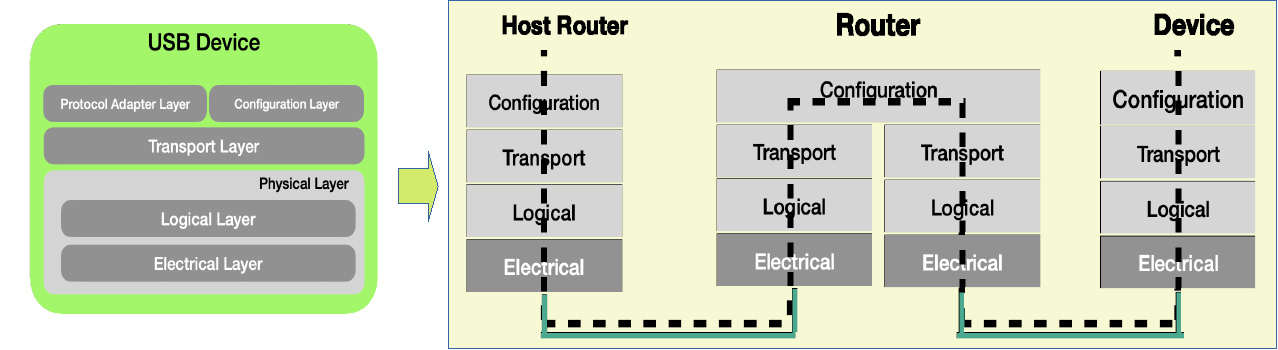
Figure 8. USB 4 function stack layers [24].